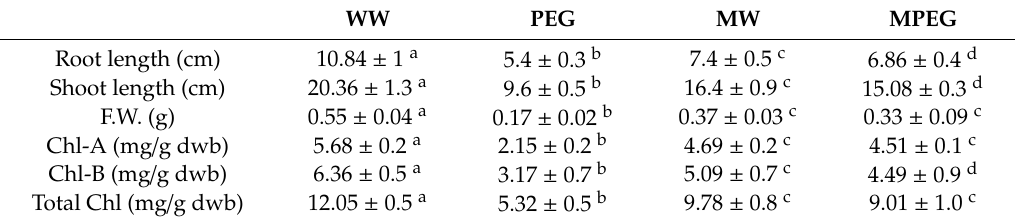
Table 2. Impact of melatonin application on the growth parameters and chlorophyll content of oat plants exposed to PEG-induced osmotic stress. WW, well-watered oat plants (control); PEG, oat plants exposed to 20% PEG for 7 days; MW, oat plants exposed to melatonin for 7 days then watered normally for 10 days; MPEG, plants treated with melatonin for 7 days then exposed to 20% PEG for 10 days. Values are the mean ± SE of three independent assays of four replicates in each treatment. Di ff erent letters in each row indicate significant di ff erences ( p ≤ 0.05) between treatments; Tukey’s test ( n = 5).